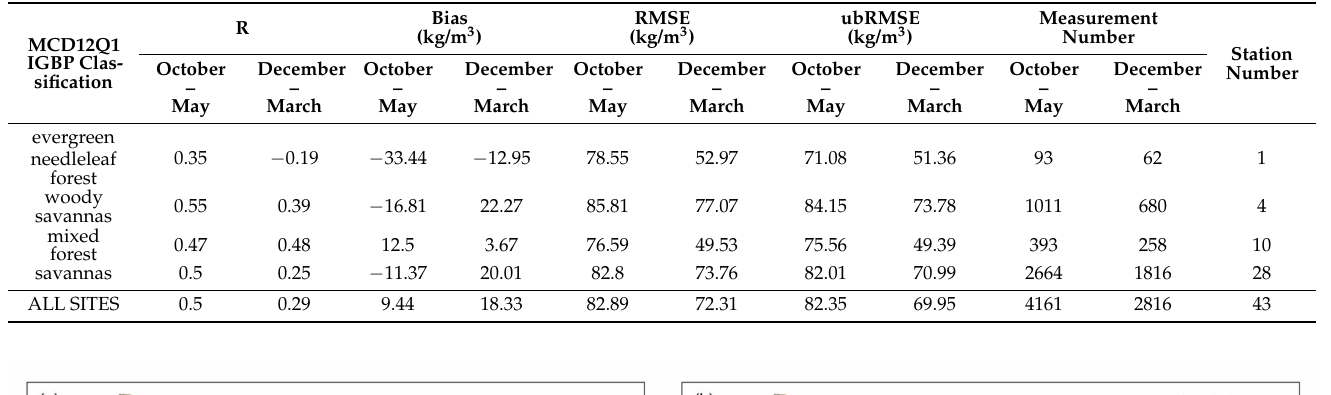
Table 1. The validation metrics of retrieved snow density compared with in-situ measurements summarized based on the MCD12Q1 IGBP classification.